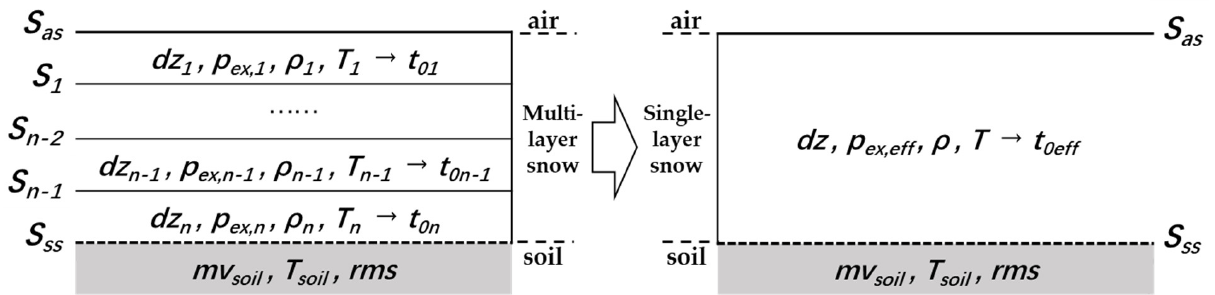
Figure 6. Concept of simplification of a multiple-layer snowpack to a single-layer snowpack. ( d z , p ex , ρ , and T respectively refer to snow thickness, exponential correlation length, density, and temperature of each snow layer, and p ex_eff refers to the effective p ex . S as and S ss are the reflectivity of air–snow and snow–soil boundaries, and S 1 to S n − 1 refer to the reflectivity of interfaces between snow layers. t 01 , t 02 . . . t 0 n are the one-way transmissivity of each snow layer, and t 0 eff is the effective single-layer value. mv soil , T soil and rms refer to moisture, temperature and roughness of soil.).